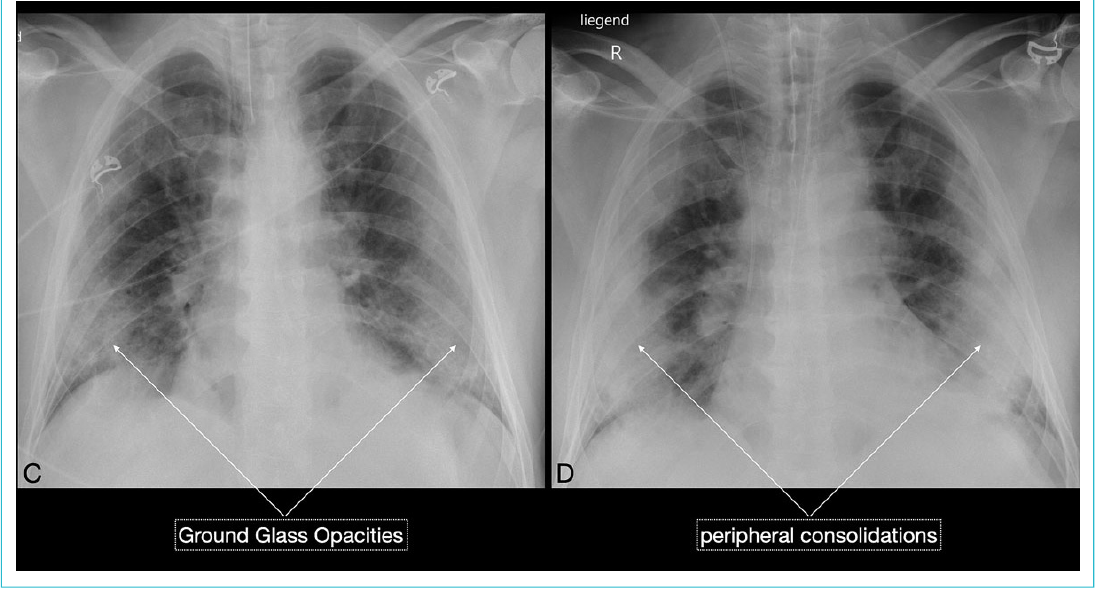
Figure 3 CD: Chest x-ray (C) revealed extensive peripheral ground glass opacities, which became more consolidated (D) over the next 5 days.